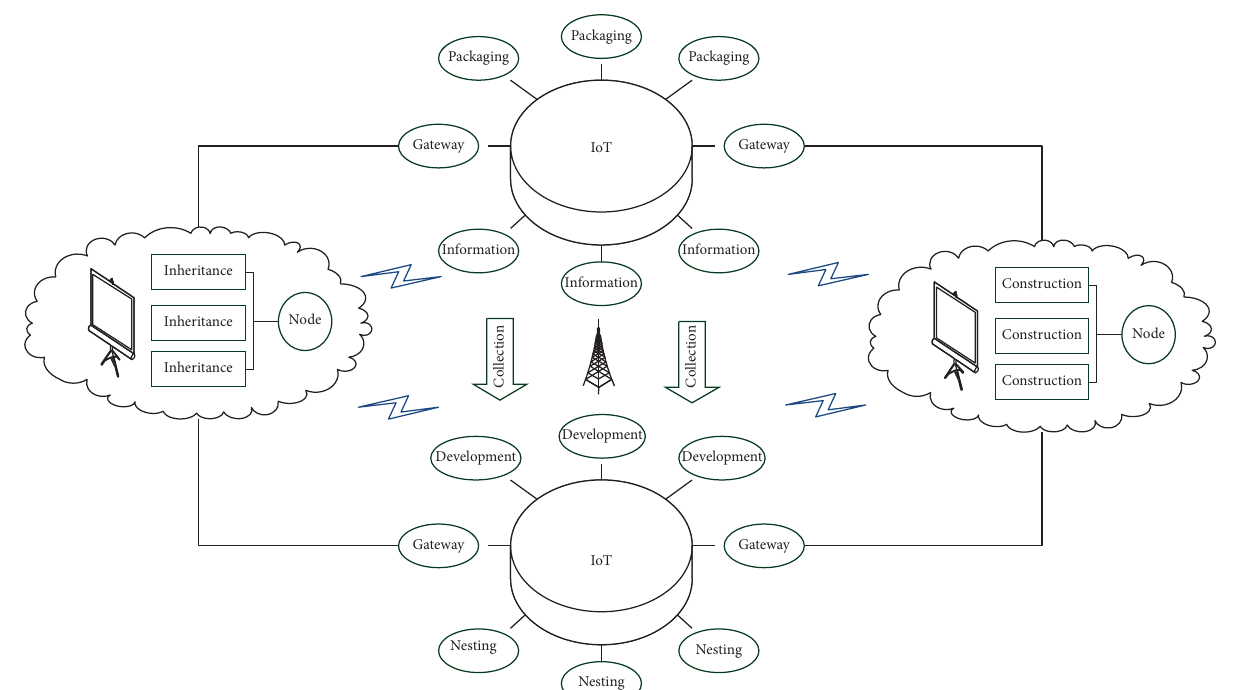
Figure 1: Hierarchical structure of 5G Internet of Things